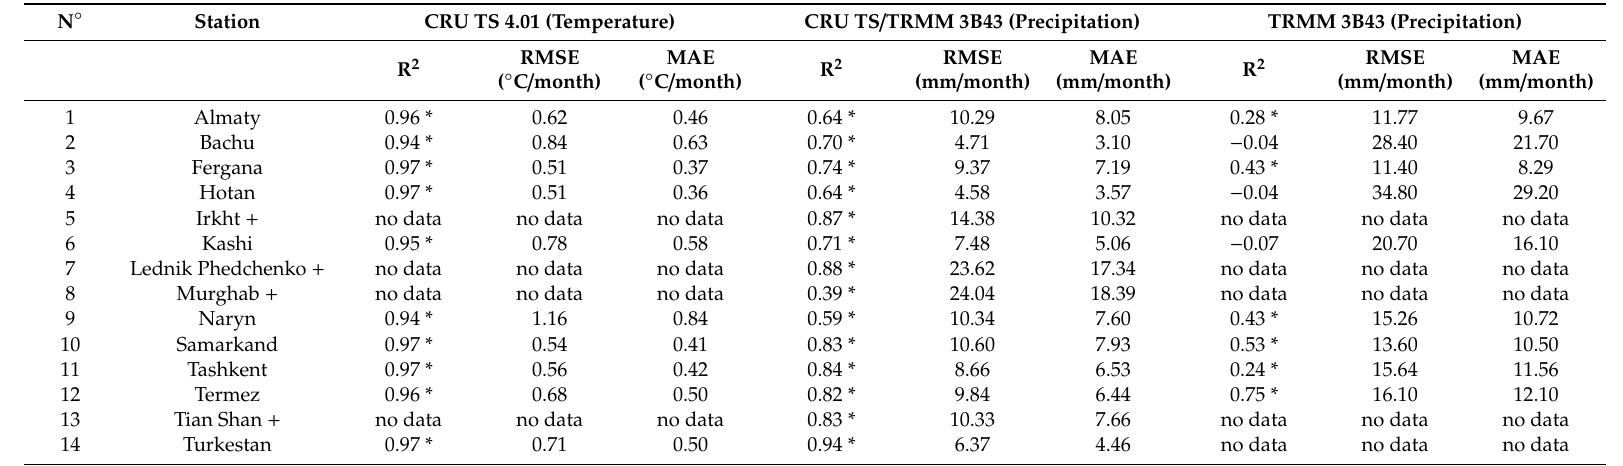
Table 2. Performance measurements of CRU TS 4.01 (temperature), TRMM 3B43 (precipitation), and CRU TS / TRMM 3B43 (precipitation) against 14 di ff